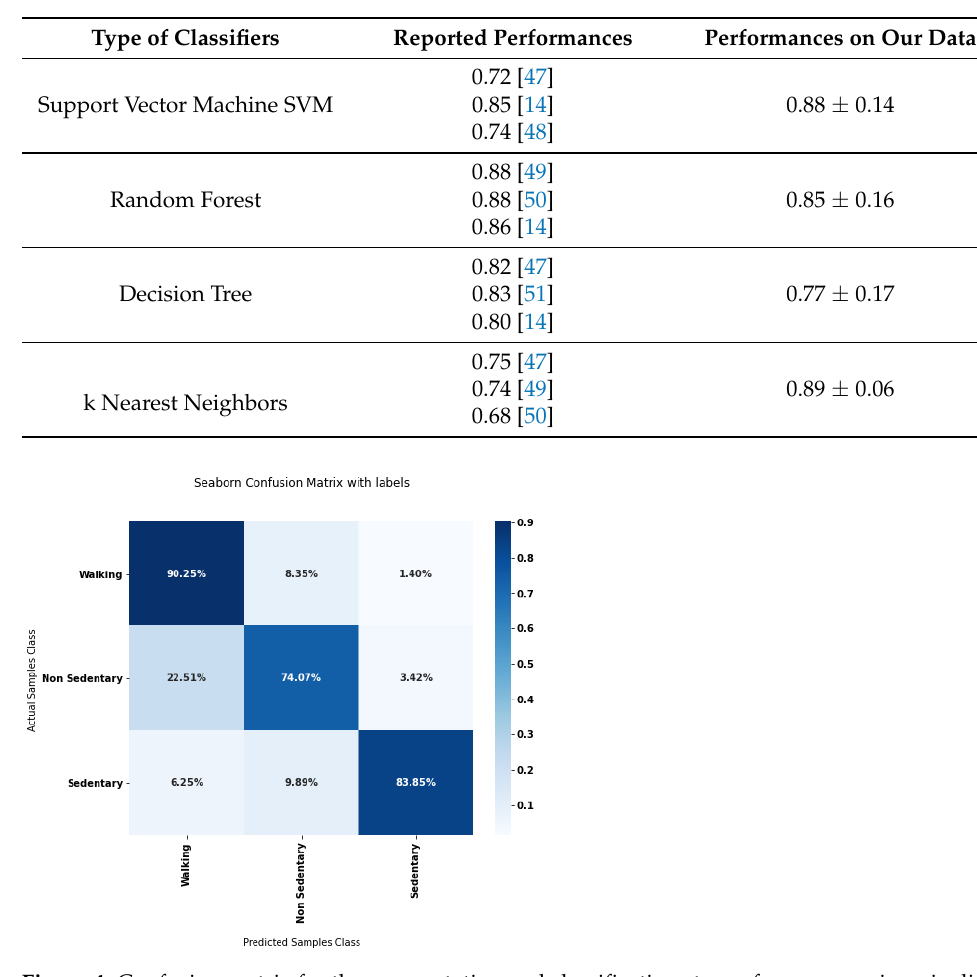
Figure 4. Confusion matrix for the segmentation and classification steps of our processing